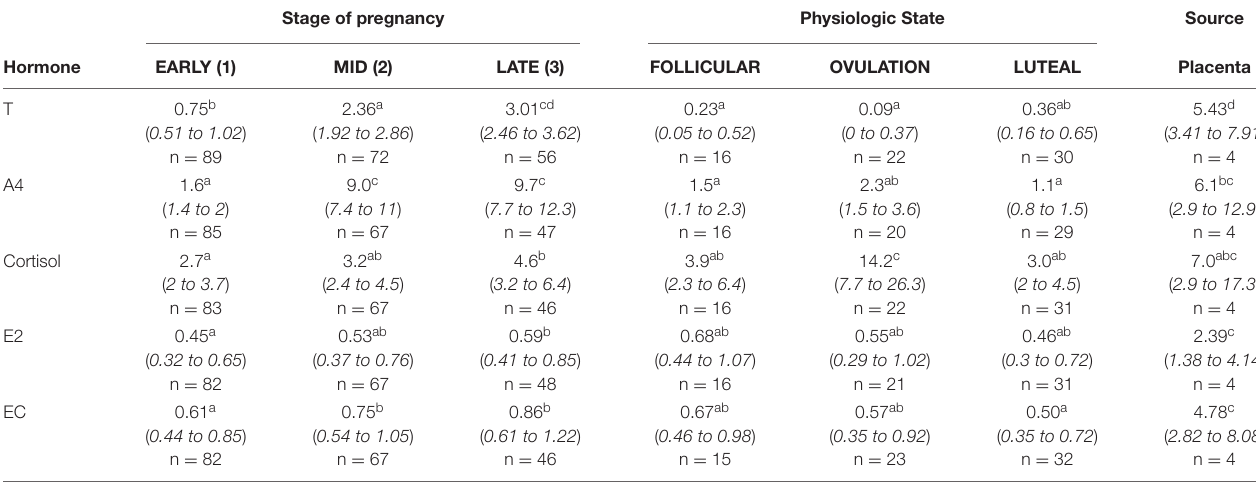
TABLE 2 | Marginal mean ( 95% CI ) hormone concentration (ng/ml) of testosterone (T), androstenedione (A4), cortisol, estradiol (E2) and estrone conjugates (EC) during each stage (EARLY, MID, LATE) of normal pregnancies, the follicular phase (FOLLICULAR), OVULATION and the luteal phase (LUTEAL) in bottlenose dolphins. Stage of pregnancy Physiologic